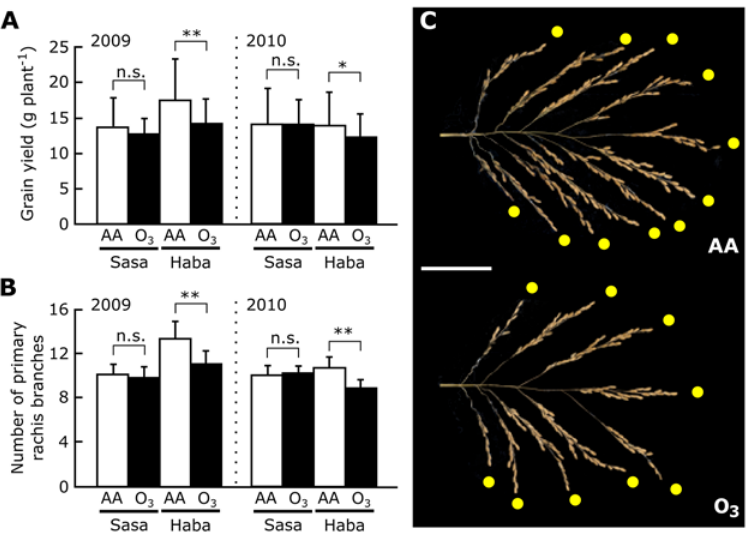
Fig 1. Effects of elevated ozone on two rice cultivars, Sasanishiki and Habataki. (A) Changes in grain yield in 2009 and 2010. (B) Changes in the number of primary rachis branches in 2009 and 2010. Values are mean ± SD ( n = 20). Error bars indicate SD; n.s., not significant; * P < 0.1; ** P < 0.05 (Student ’ s t -test). AA, ambient air; O 3 , elevated ozone; Sasa, Sasanishiki; Haba, Habataki. (C) Typical panicles of Habataki grown under ambient air (left) or elevated ozone (right). Yellow circles indicateidentify each primary rachis branches. Scale bar = 5